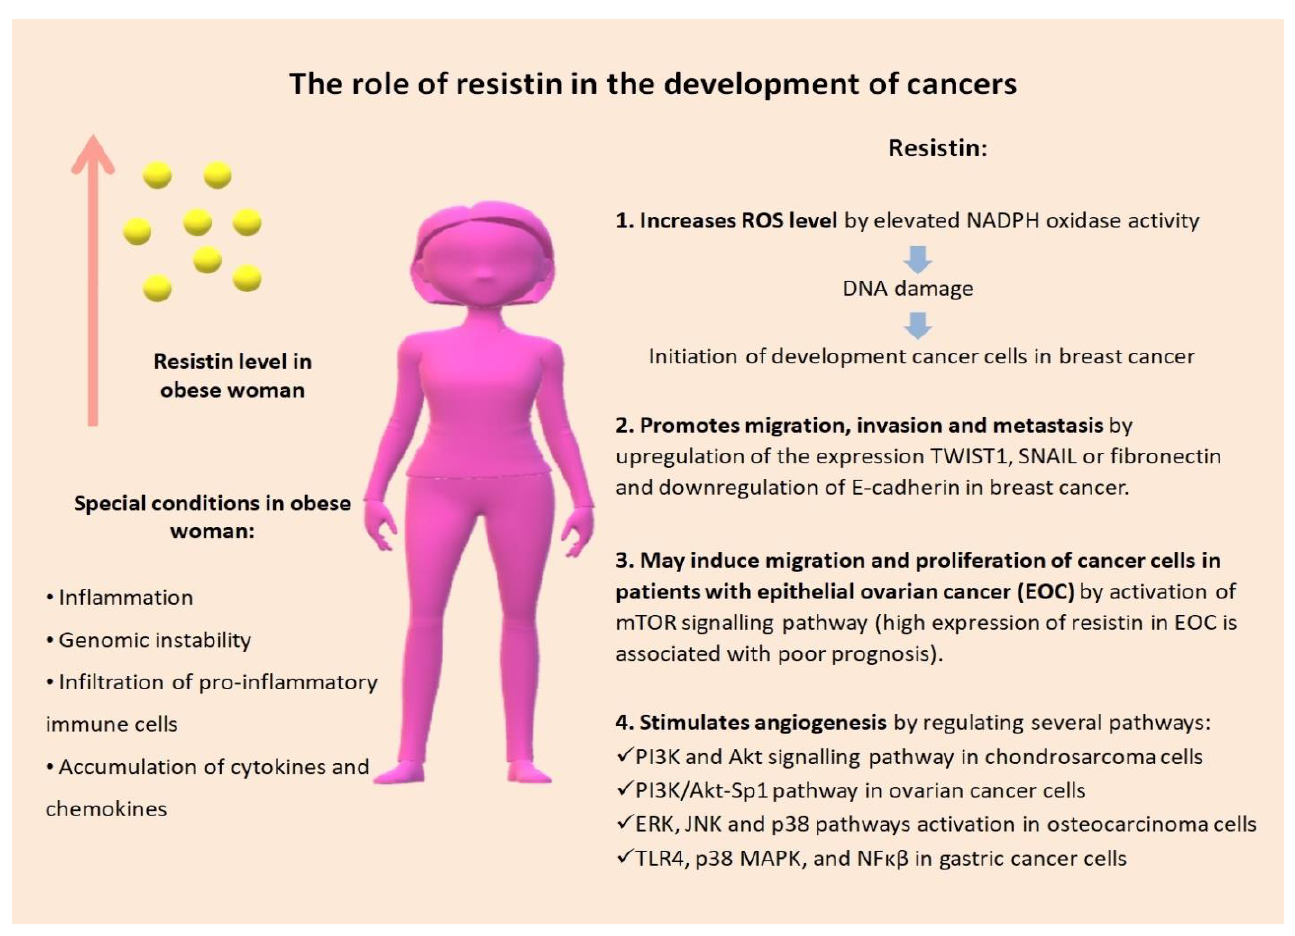
Figure 1. The complex role of resistin in cancer development [31,78,96–100]. Reactive oxygen species (ROS); nicotinamide adenine dinucleotide phosphate (NADPH); mammalian target of rapamycin (mTOR); phosphatidylinositol 3-kinase (PI3K); protein kinase B (Akt); specificity protein 1 (Sp1); extracellular signal-regulated kinase (ERK); c-Jun N-terminal kinase (JNK); toll-like receptor 4 (TLR4); mitogen activated protein kinase (MAPK); transcription factor nuclear factor-kappa B (NFκβ) .